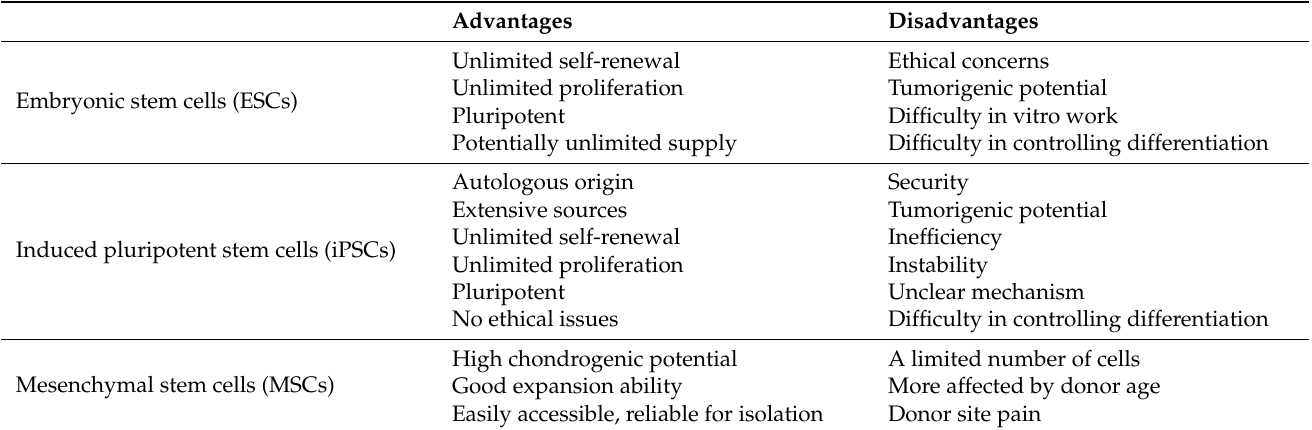
Table 3. Summary of advantages and disadvantages of ESCs, iPSCs, and